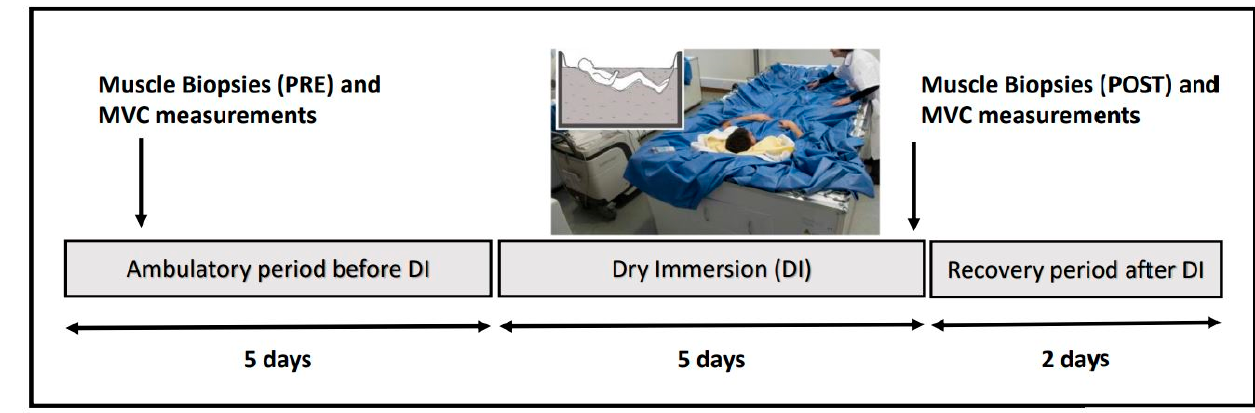
Figure 1. Experimental protocol. Subjects arrived in the evening 5 days before DI and left 2 days after DI in the morning. The experimental protocol included four days of ambulatory baseline measurements before immersion, five days of dry immersion, and two days of ambulatory recovery. Baseline and post measurement included muscle biopsy of the vastus lateralis and maximal voluntary contraction measurement (MVC). Subjects randomized to cuff group wore the thigh cuffs during the 5 days of DI, from 10 h to 18 h the first day and from 8 h to 18 h the other as at counter-pressure of 30–50 mmHg.